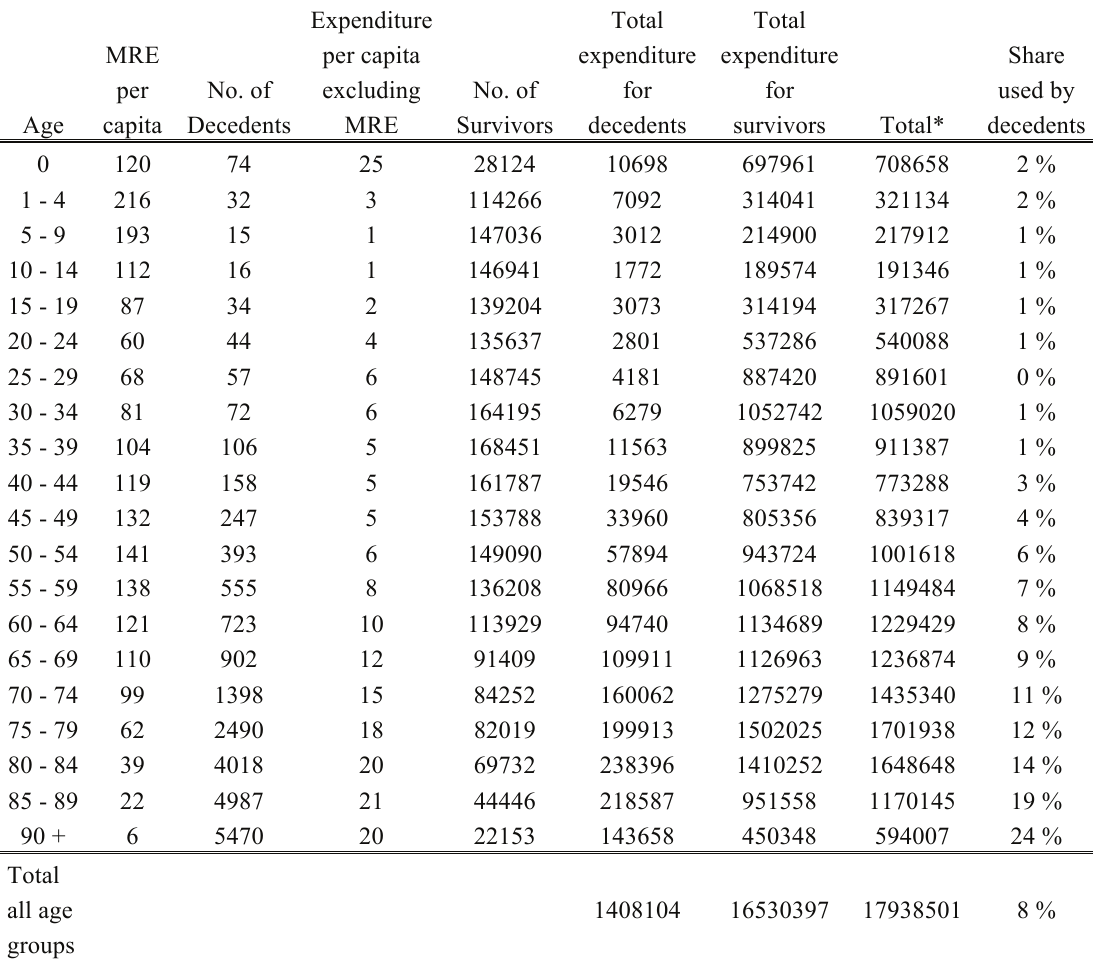
Table 4b: Estimated expenditures in 1000 NOK for females per